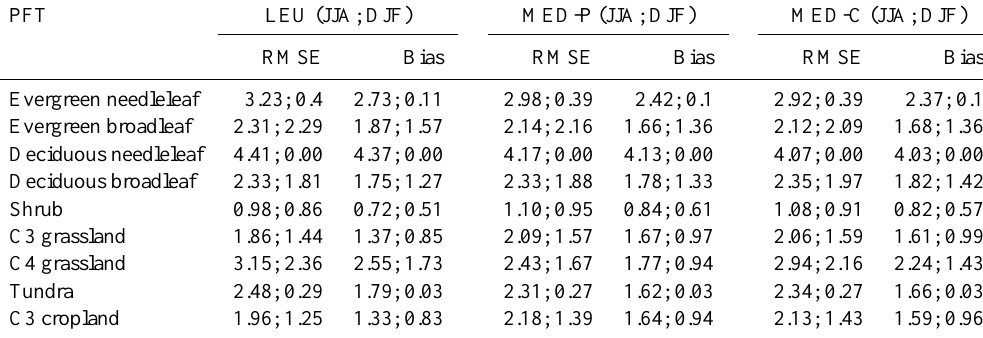
Table 8. Summary statistics for December-January-February (DJF) June-July-August (JJA), describing the root mean squared error (RMSE) and bias between the FLUXNET-MTE GPP product and the CABLE